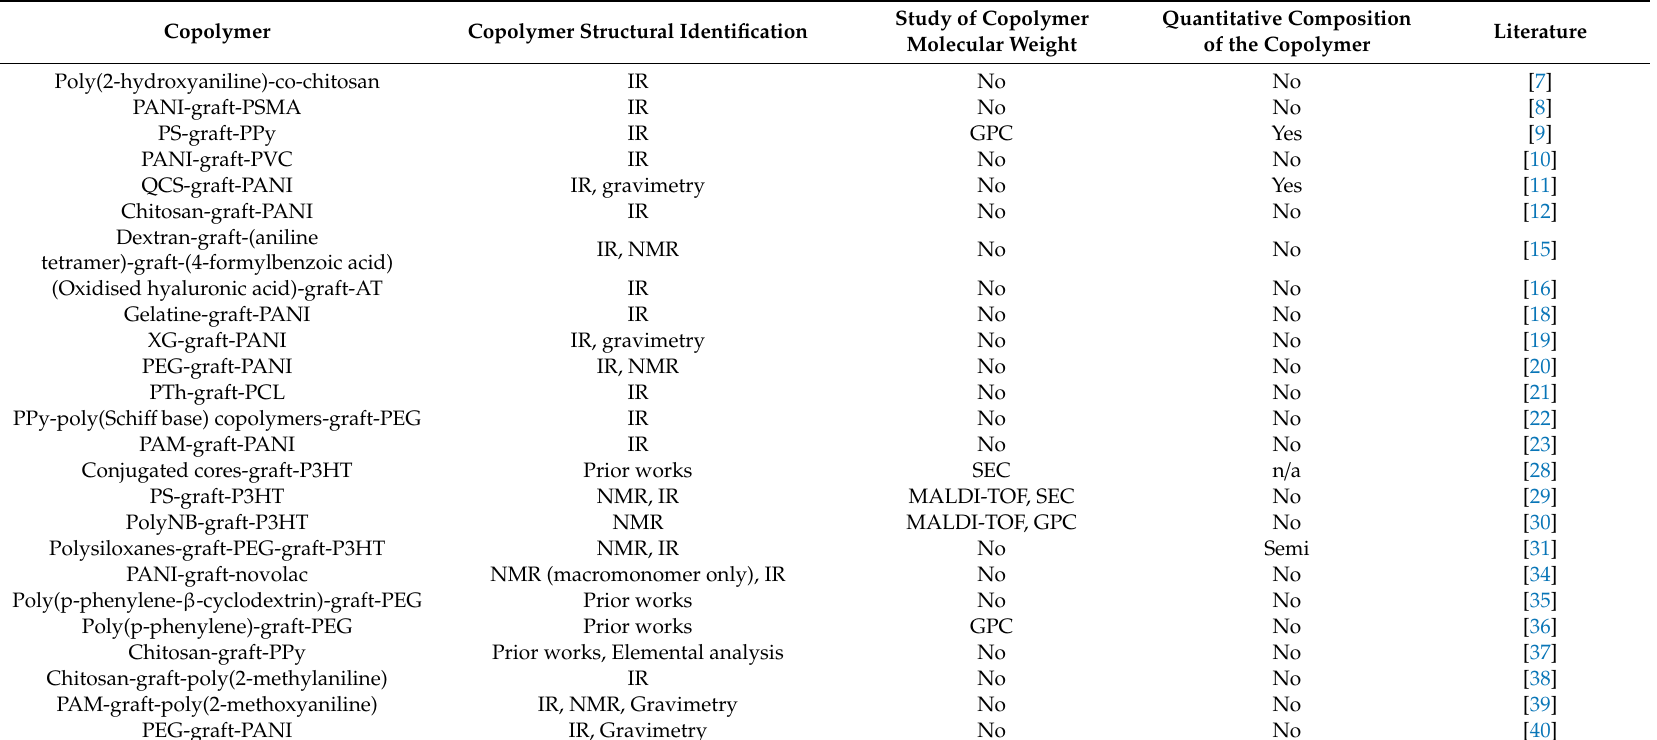
Table 1. Summary of the structural identification methods used in the reviewed